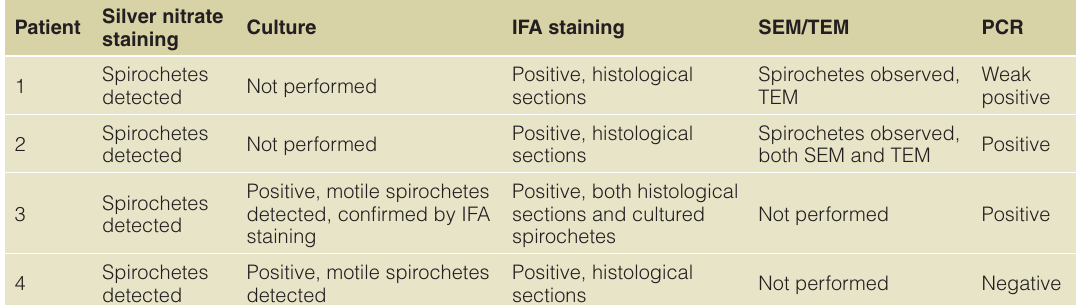
Table 2. Summary of laboratory findings in Morgellons disease